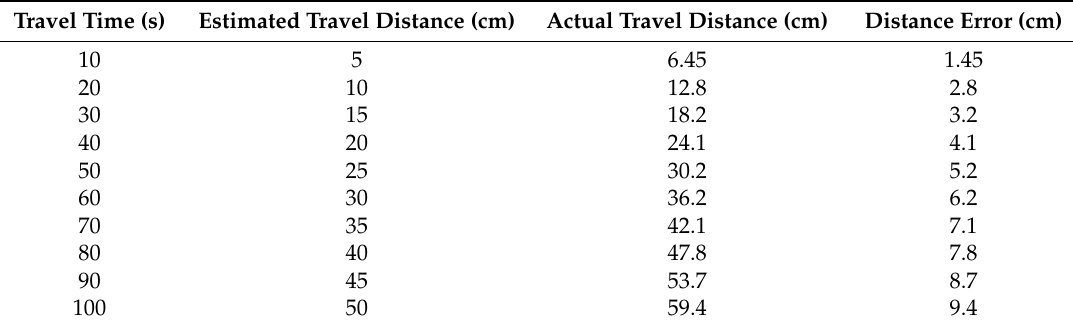
Table 3. Travel Distance—General Estimation.